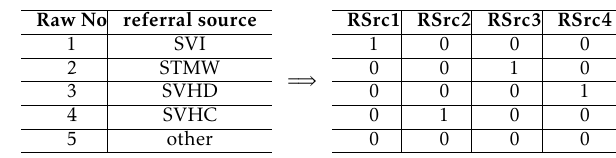
Table 6. Comparison of Before and After One Hot Encoding